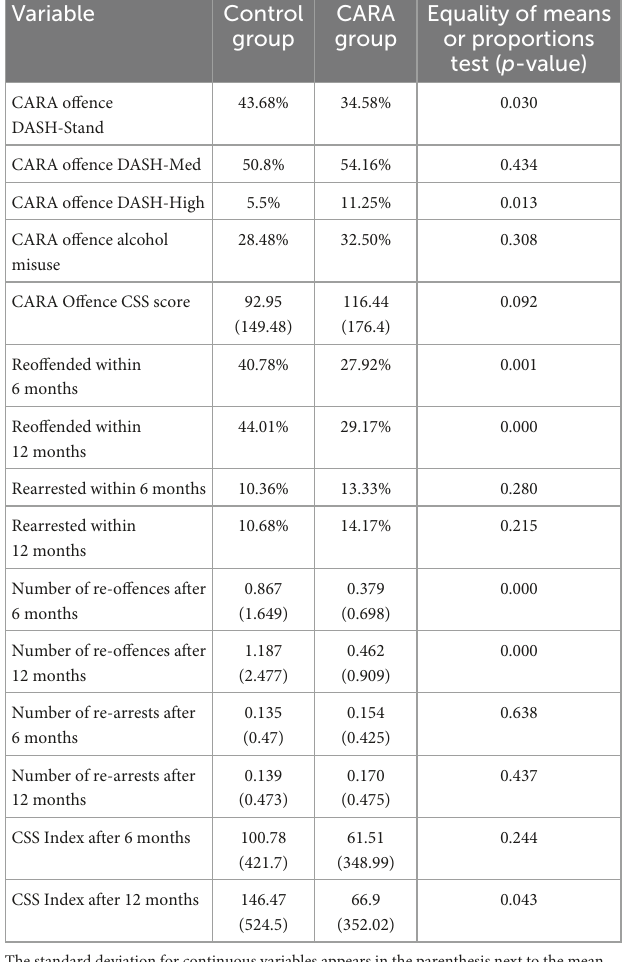
TABLE 5 Hampshire Constabulary Data Descriptive Statistics - Means of General offender characteristics.